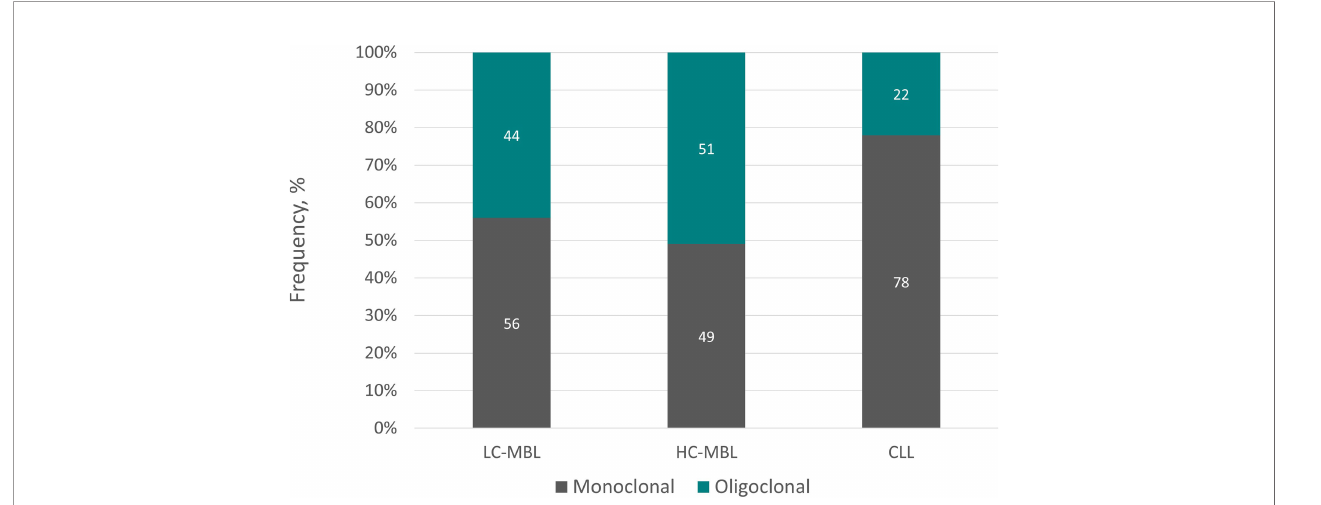
FIGURE 3 | Monoclonal versus oligoclonal case distribution in LC-MBL, HC-MBL and CLL. Data regarding LC-MBL were extracted from Agathangelidis et al. (46) and Henriques et al. (26), whereas the data concerning HC-MBL and CLL were obtained from the